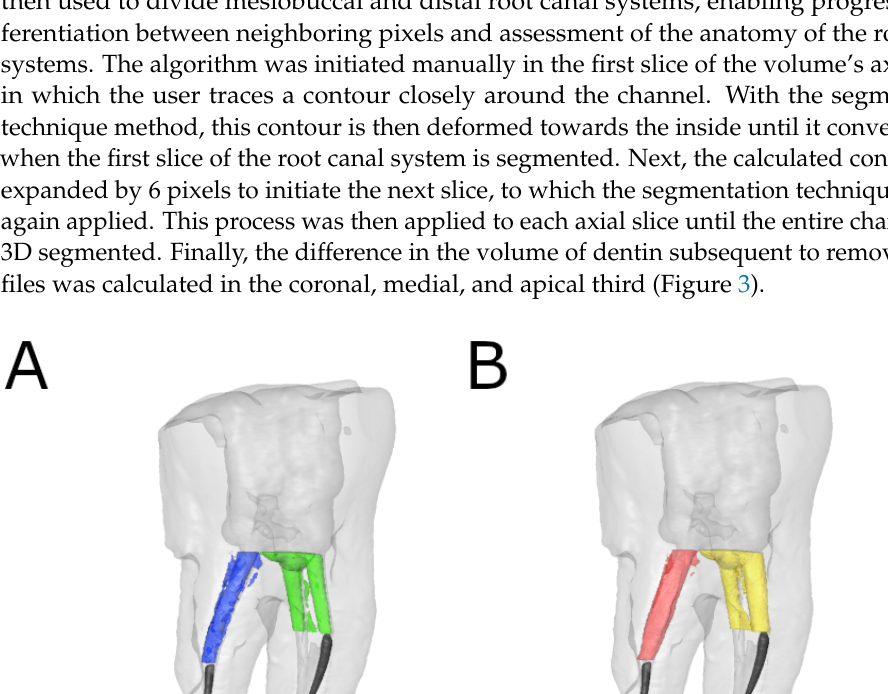
Figure 2. Reconstructed 3D micro-CT images of ( A ) preoperative and ( B ) postoperative ER study group and ( C ) preoperative and ( D ) postoperative US study group. Preoperative (blue) and post- operative (red) distal root canal and preoperative (green) and postoperative (yellow) mesial root canals were isolated. The fractured NiTi endodontic rotary files (black) were also isolated in both distal and mesiobuccal root canal systems. Next, the teeth were reconstructed, with a 25-micron resolution per voxel (Quantum 3.0, San Jose, CA, USA). An advanced image segmentation technique based on partial dif- ferential equations (Level Sets, National Institutes of Health, Bethesda, MD, USA) was then used to divide mesiobuccal and distal root canal systems, enabling progressive dif- ferentiation between neighboring pixels and assessment of the anatomy of the root canal systems. The algorithm was initiated manually in the first slice of the volume’s axial view, in which the user traces a contour closely around the channel. With the segmentation tech- nique method, this contour is then deformed towards the inside until it converges, i.e., when the first slice of the root canal system is segmented. Next, the calculated contour was expanded by 6 pixels to initiate the next slice, to which the segmentation technique is once again applied. This process was then applied to each axial slice until the entire chan- nel was 3D segmented. Finally, the difference in the volume of dentin subsequent to re- moval of the files was calculated in the coronal, medial, and apical third (Figure 3).